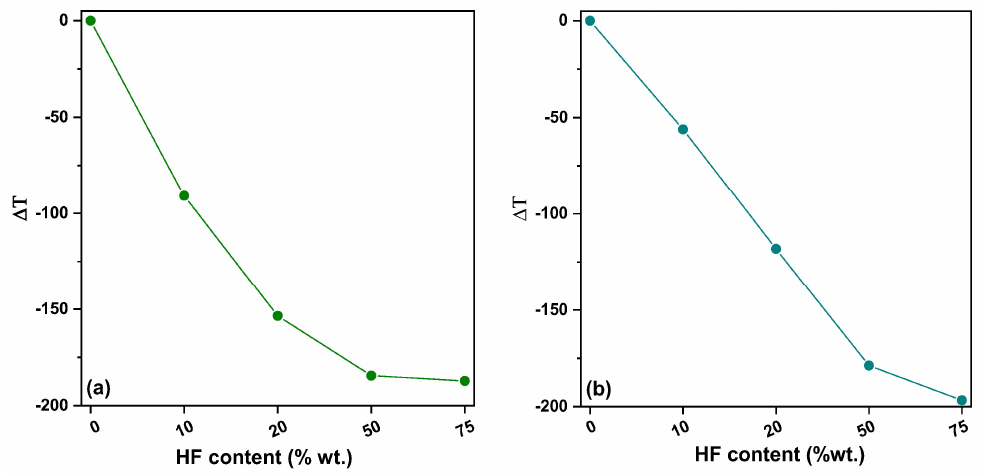
Figure 8. Plots of the thermal stability of the composites with respect to r-HDPE with the addition of the compatibilizers ( a ) Joncryl (JC), and ( b ) polyethylene-grafted maleic anhydride (PE-g-MA).